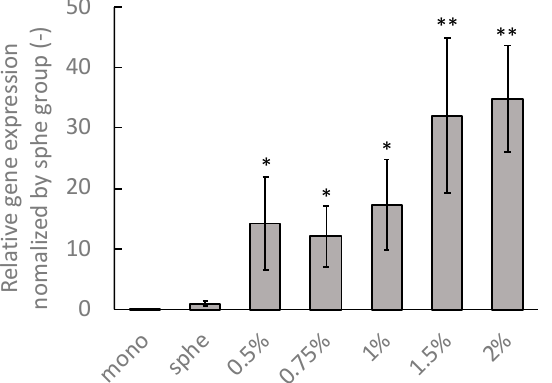
concentrations, plateauing at concentrations beyond 1.0% agarose gel.